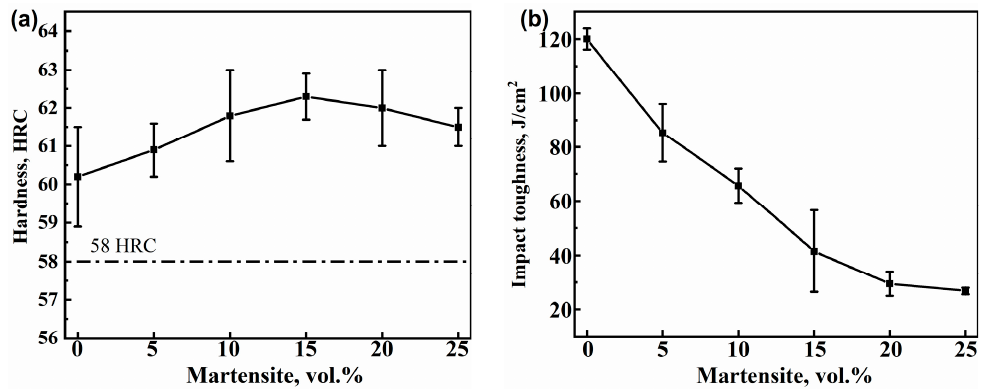
Figure 6. Mechanical properties of specimens with different treatment processes: ( a ) Hardness, ( b ) Toughness.